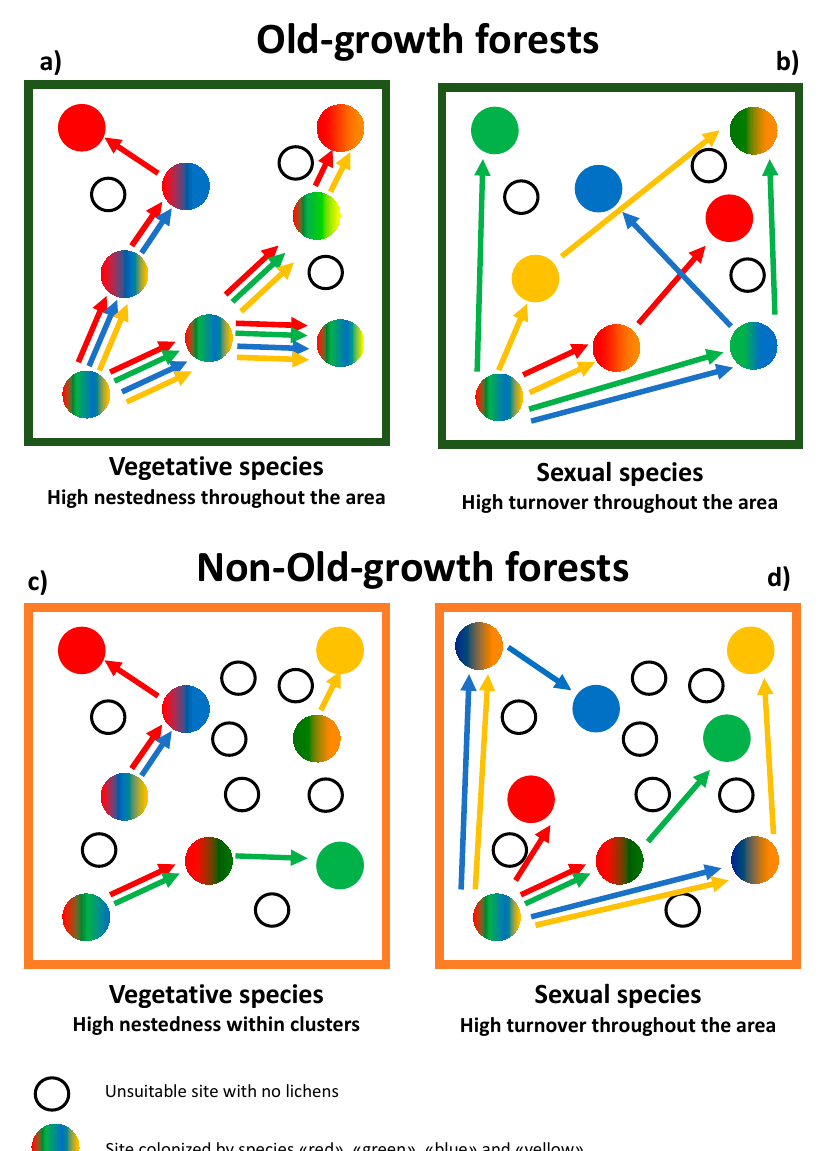
Figure 1. Schematic representation of the hypotheses tested in the study on the beta diversity patterns of lichen species with contrasting reproductive strategies in old-growth (OG) and non-old growth (NOG) forests. The squares represent the areas with different types of forest. We report the possible dispersion flows (arrows) of the different species (colors) between sites (circles) that determine the colonization and are the basis of the potential compositional differences: ( a ) vegetative species in OG forests; ( b ) sexual species in OG forests; ( c ) vegetative species in NOG forests; ( d ) sexual species in NOG forests.